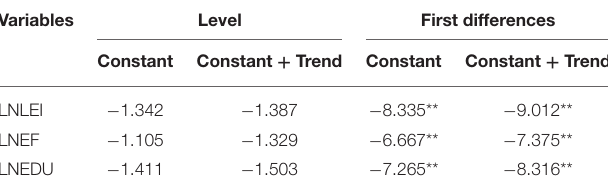
TABLE 4 | Results of the CIPS unit root test.